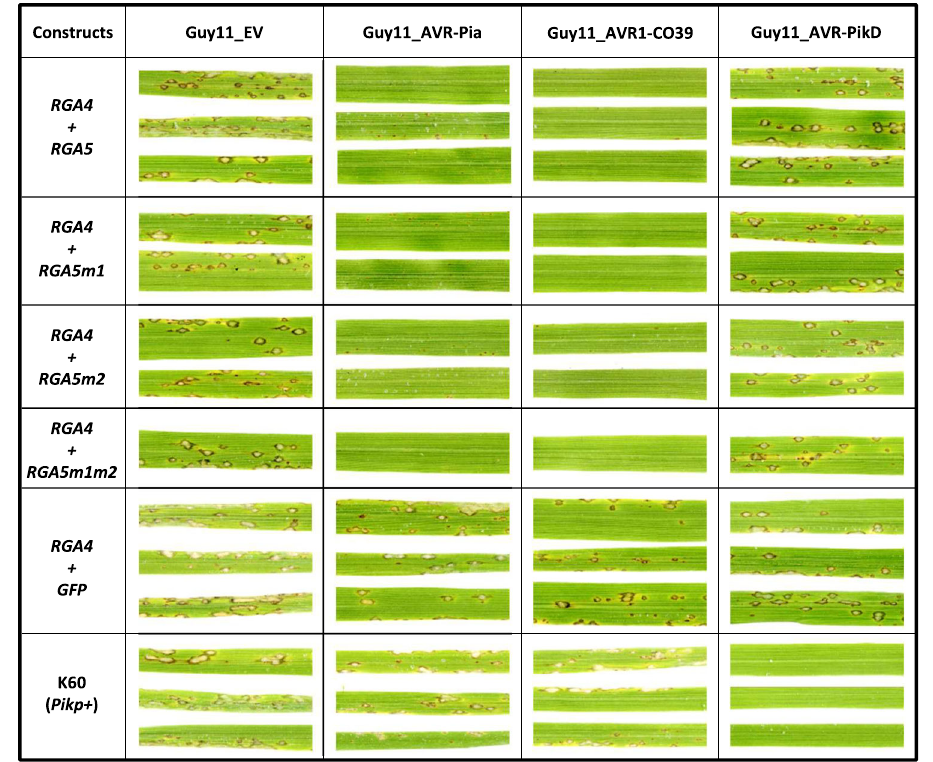
Fig. 8 The RGA5 m1, m2, and m1m2 mutants recognize AVR-Pia but not AVR-PikD in rice. The rice cultivar Nipponbare was co-transformed with a genomic construct for RGA4 and a genomic construct for RGA5 , RGA5m1 , RGA5m2 , or RGA5m1m2 . A transgenic line carrying RGA4 and GFP was also generated as a control. T1 plants of the transgenic lines were spray inoculated with the transgenic strains Guy11-AVR-Pia, Guy11-AVR1-CO39, Guy11-AVR- PikD, or Guy11-EV. The rice cultivar K60 carrying the Pikp resistance was used as a control for AVR-PikD speci fi c recognition. Pictures show representative symptoms at 7 days after inoculation. Individual leaves indicate independent T1 transgenic lines. Similar results were obtained in two independent inoculation experiments performed on T0 (Supplementary Fig. 8) and T2 (Supplementary Fig. 9)